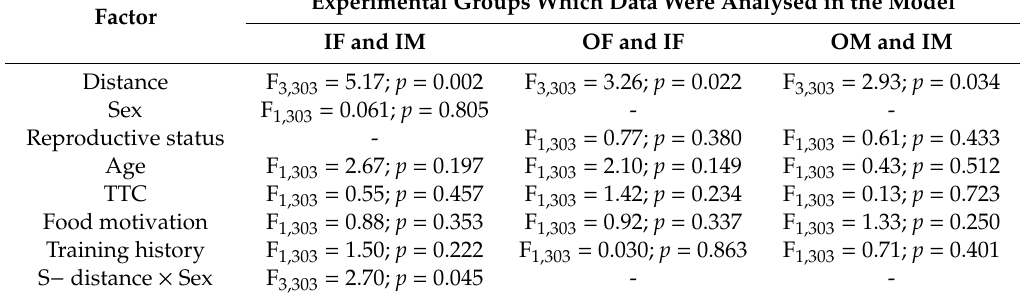
Table 4. Results of the Generalized Linear Mixed Models investigating the e ff ect of the distance of the bowl with the smaller amount of food, the dog’s sex or reproductive status (investigated in separate models, and with di ff erent data subsets), age, food motivation, type of training received, and number of trials needed to reach the learning criterion in the Training phase (TTC). Only significant first-order interactions between distance and other factors are reported. IF = intact females, IM = intact males, OF = ovariectomized females, OM = orchiectomized males. Subscript numbers indicate the numerator and denominator degrees of freedom,